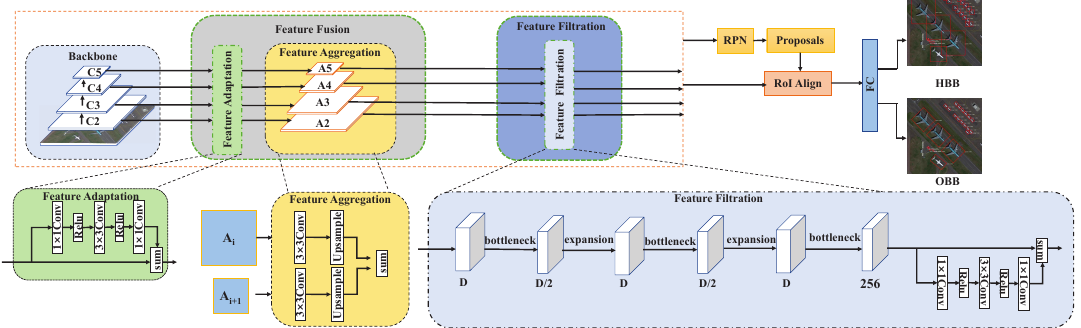
Figure 2. Framework of the proposed F 3 -Net. F 3 -Net consists of four main components: backbone for feature extraction, feature fusion module for multi-resolution multi-level feature combination, feature filtration module for compact feature representation, and detection module for object classification and regression. ( A i means the features produced by feature adaptation